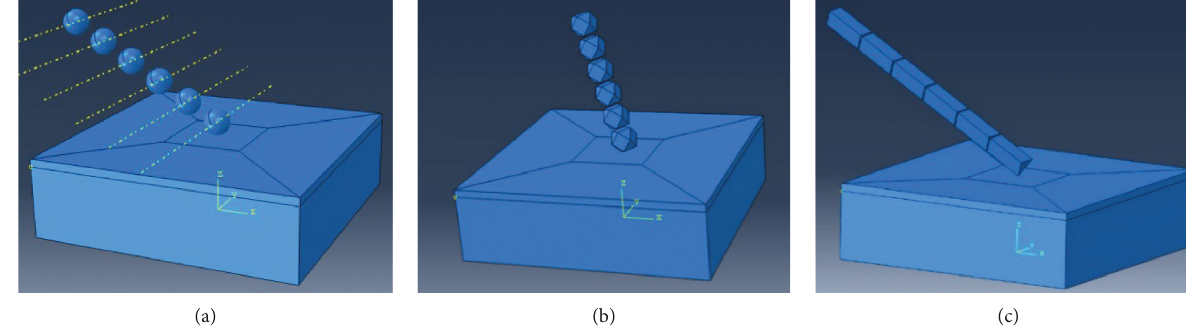
Figure 2: Geometric model of the impact target. (a) Spherical model. (b) Tetrakaidecahedron model. (c) Triangular prism